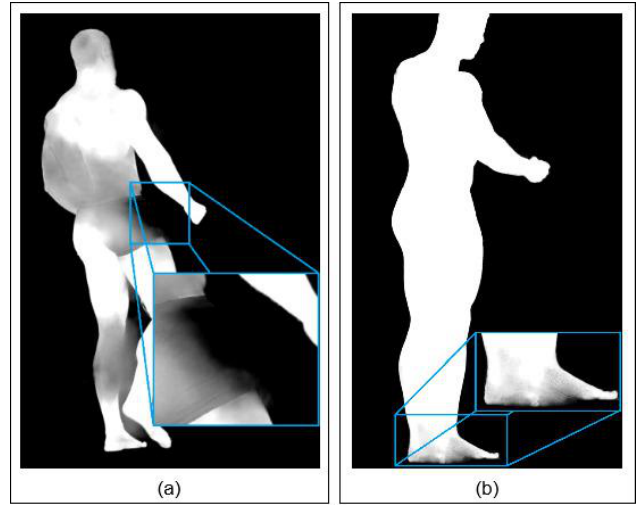
Figure 12. Examples of erroneous silhouette areas: ( a ) torso, left leg, and head; ( b ) feet.